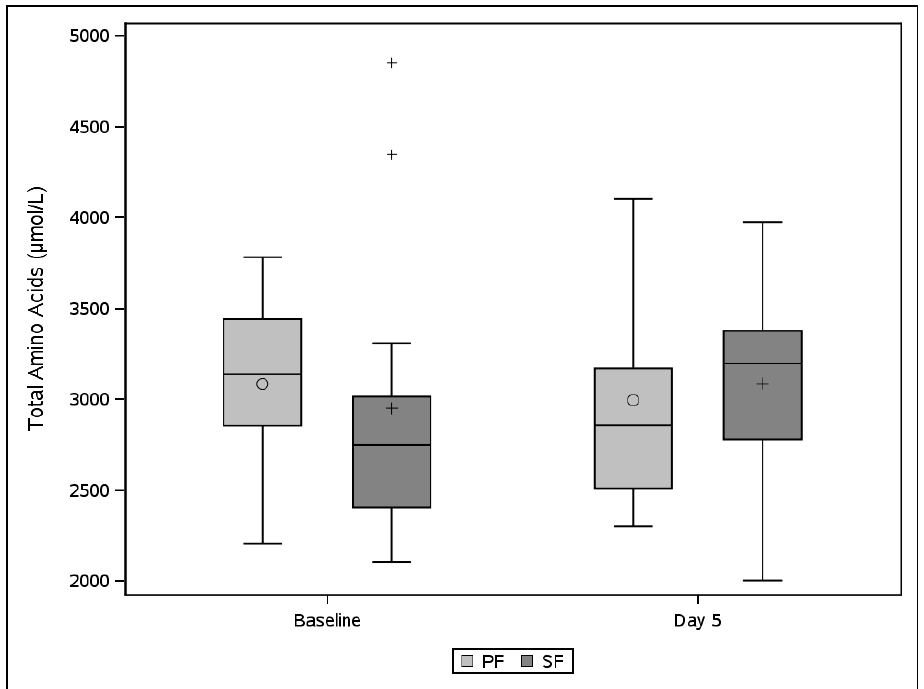
Figure 1. Plasma amino acid concentration. Total plasma amino acid concentration (µmol/L) at baseline and day 5 comparing the peptide formula (PF) and the standard formula (SF) groups.